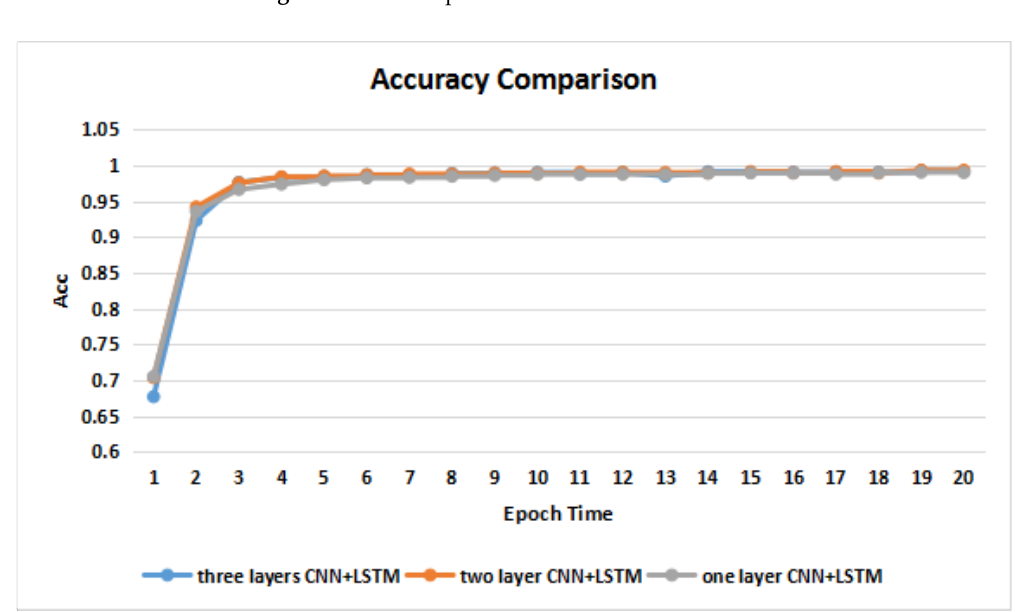
Figure 4. Loss comparisons across different models.